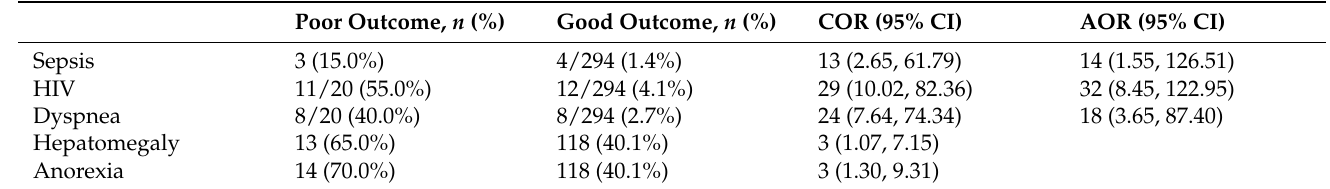
Table 3. Bivariate and multivariate analysis of predictors of poor clinical outcomes among VL patients during the time of admission at LRTC, Gondar,